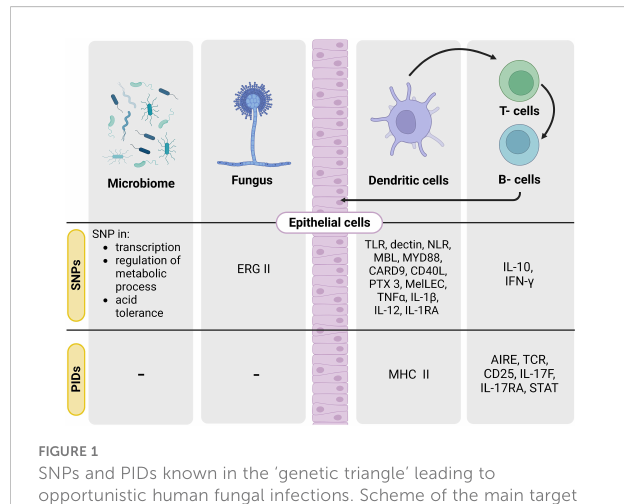
FIGURE 1 SNPs and PIDs known in the ‘ genetic triangle ’ leading to opportunistic human fungal infections. Scheme of the main target genes involved in SNPs and PIDs leading to the main described human fungal diseases. Single nucleotide polymorphisms (SNPs), primary immunode fi ciencies